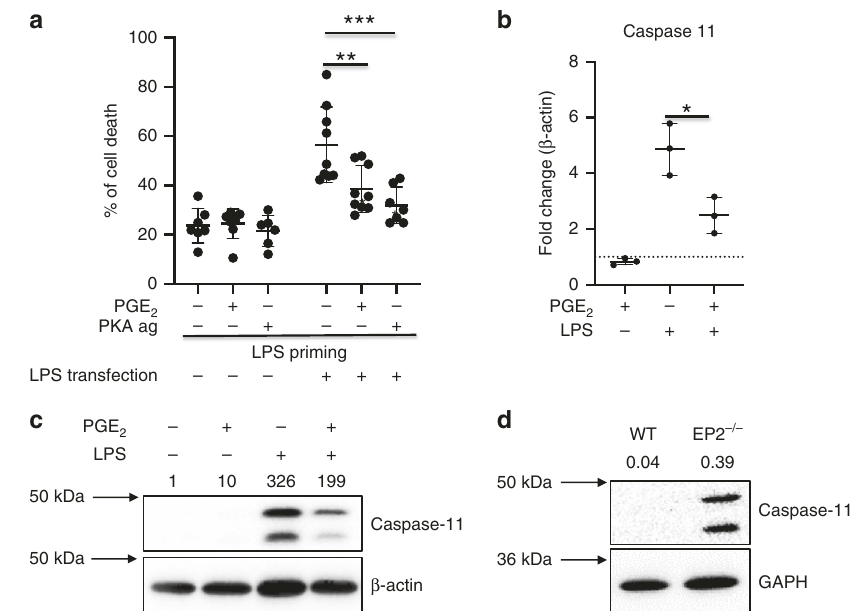
Fig. 1 Prostaglandin E2 protects against pyroptosis. a Murine BMDMs were treated with 1 μ M PGE 2 or 500 μ M 6-Bnz-cAMP (PKA ag) for 30 min followed by priming with 100 ng/ml of LPS for 4 h and 2 μ g of LPS transfection using FuGENE 0.25% v/v liposomes o/n. Supernatants were collected and analyzed for cell death using an LDH assay. The results shown are from three independent experiments (with 2 – 4 mice per group in each experiment. Individual data points on the graph represent means from two to three technical replicates). Ordinary one-way ANOVA with Tukey ’ s multiple comparison test has been used, ** P < 0.01, *** P < 0.001, error bars represent mean ± SD. b BMDMs were treated with 1 μ M PGE 2 or DMSO for 30 min followed by 100 ng/ml LPS for 4 h, and subjected to qPCR analysis of caspase-11 expression. The results shown are from a single experiment, with three mice in each group, and are representative of three independent experiments; individual data points on the graph are means from technical duplicates. * P < 0.01, two-tailed Student ’ s t test, error bars represent mean ± SD. c BMDMs were pretreated with PGE 2 for 30 min and then treated with LPS for 4 h. Lysates were assessed with caspase-11 expression by western blotting. A representative western blot from three independent experiments is shown. d BMDMs from wild-type or EP2-de fi cient mice were assessed for caspase-11 expression by western blotting. The results shown are representative of BMDMs prepared from three mice of each genotype in a single experiment. Densitometry values are shown above each